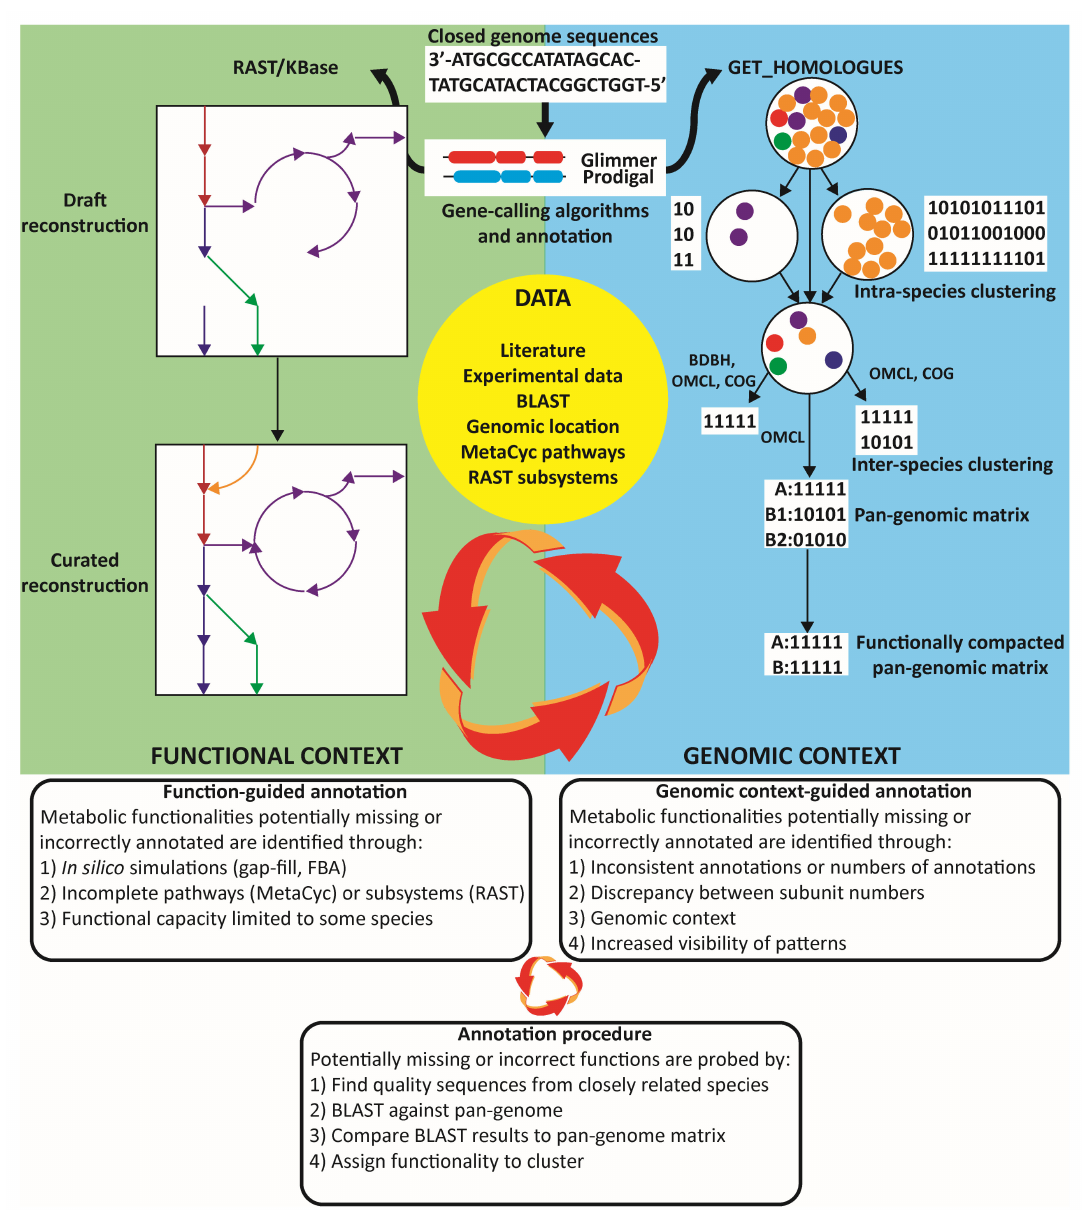
Figure 1. Graphical depiction of the bioinformatics workflow. Improved annotations of the genome, captured as a genome-scale metabolic reconstruction, are pursued using both functional approaches and genomic-context approaches that capitalize on information contained within the